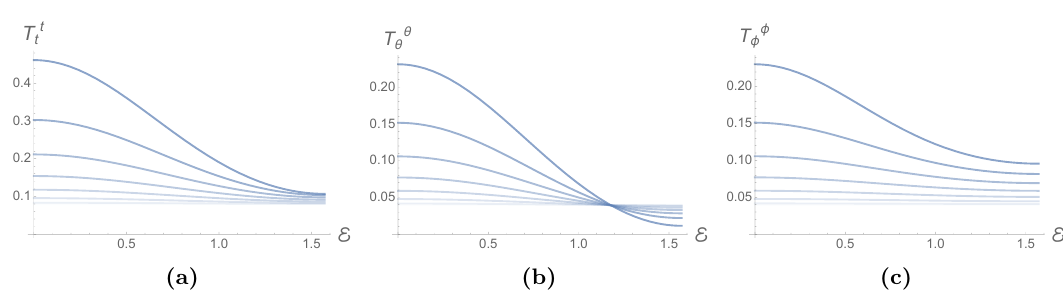
Figure 15. (a) Boundary energy density, (b) the (cid:18)(cid:18) component and (c) the (cid:30)(cid:30) component of the boundary stress tensor at T = 1 =(cid:25) . Fainter curves correspond to lower values of the electric (cid:12)eld. (Setting G N = 1.)